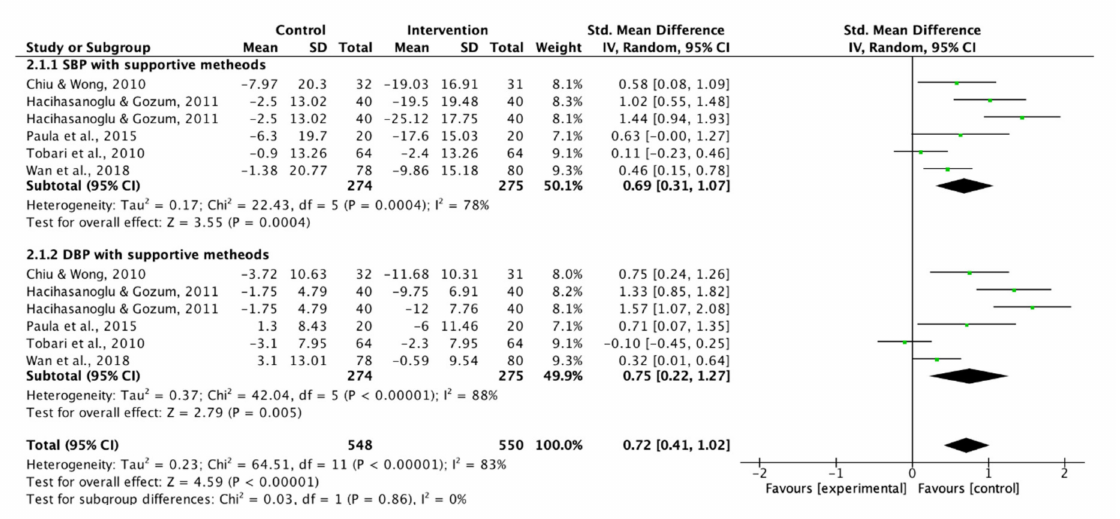
Figure 10. Forest plot of supportive methods on systolic blood pressure (SBP) and diastolic blood pressure